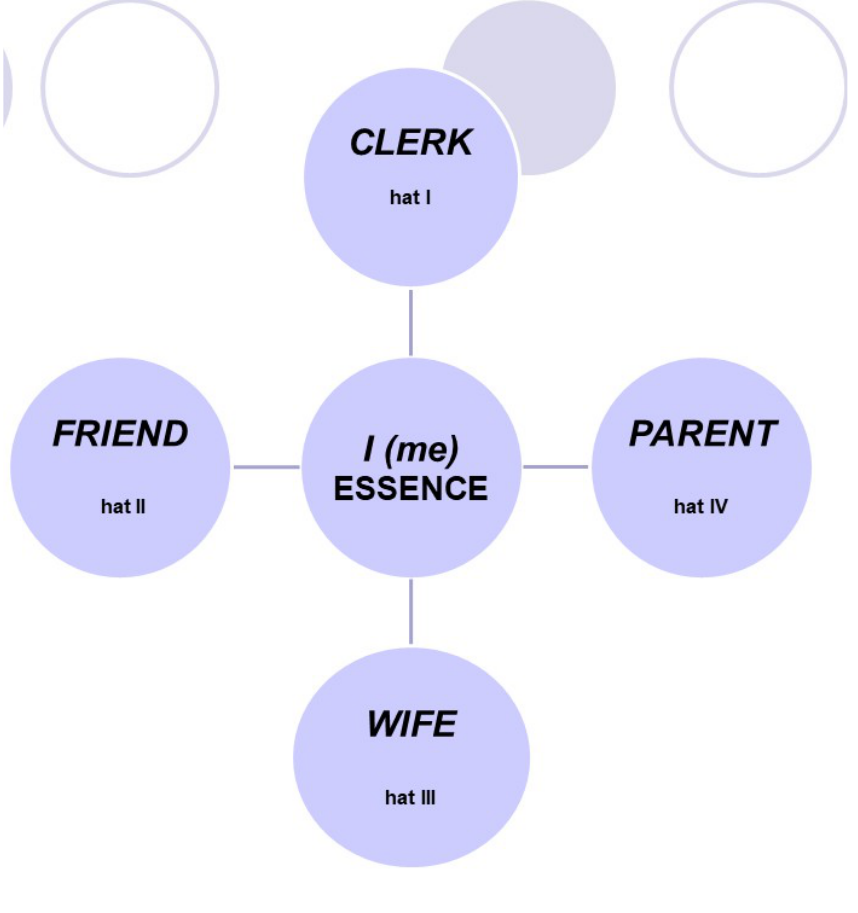
Figure 5 - ESSENCE and